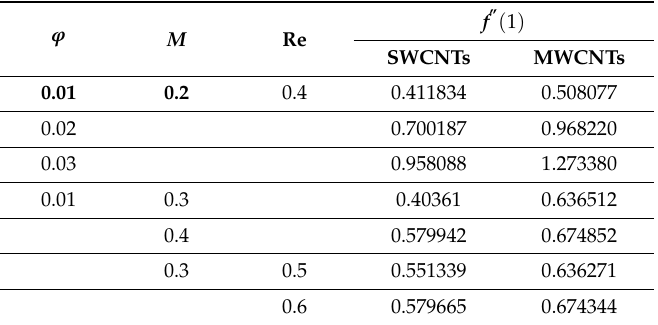
Table 3. The numerical values of the skin friction coefficient ( f (cid:48)(cid:48) ( 1 ) ). ϕ M Re